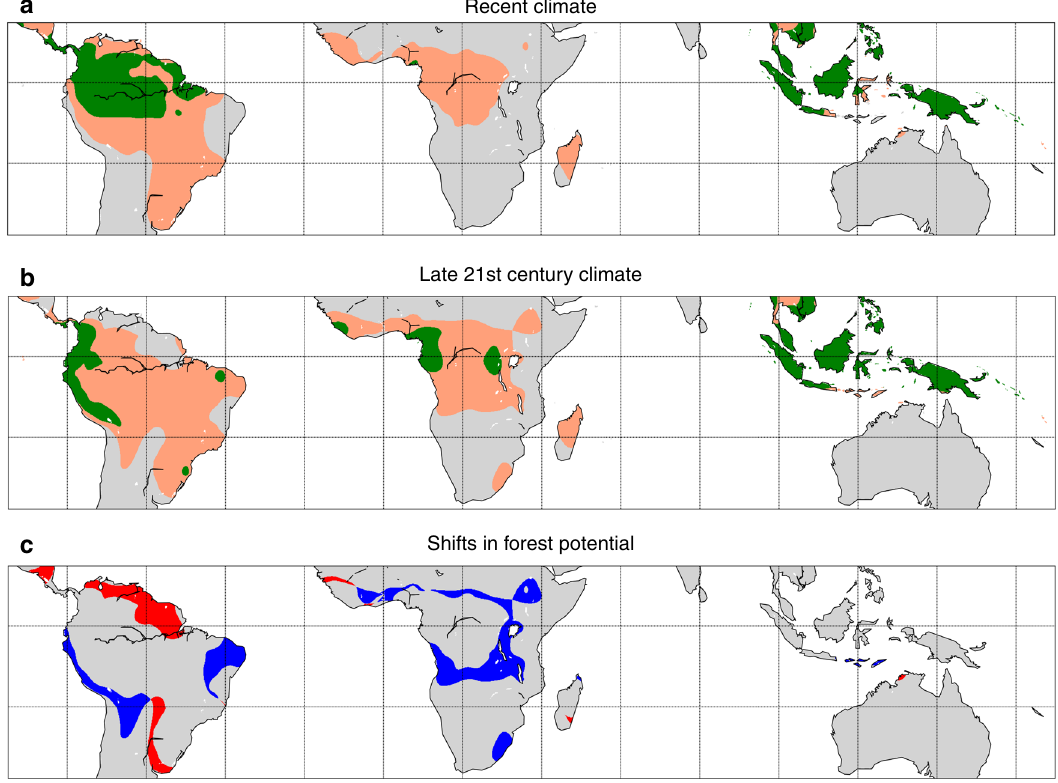
Fig. 2 Changing hysteresis of forest cover in the tropics during the 21st century. a Minimal (green) and maximal (beige) forest distributions under recent climate (2003 − 2014). b Minimal (green) and maximal (beige) forest distributions under the late 21st century climate (2071 − 2100). c Shifts in forest potential between the recent and late 21st century climates. Red areas are stable forest under the recent climate, but cross the tipping point into the nonforested rainfall range under the late 21st century climate; blue areas are too dry for forest under the recent climate, but cross the tipping point to the stable forest – rainfall range under the late 21st century climate. Note that these estimates are conservative in the sense that a rainfall change from the stable to the bistable range is assumed to have no effect on forest extent. For associated changes in rainfall, see Supplementary Figs. 6 and